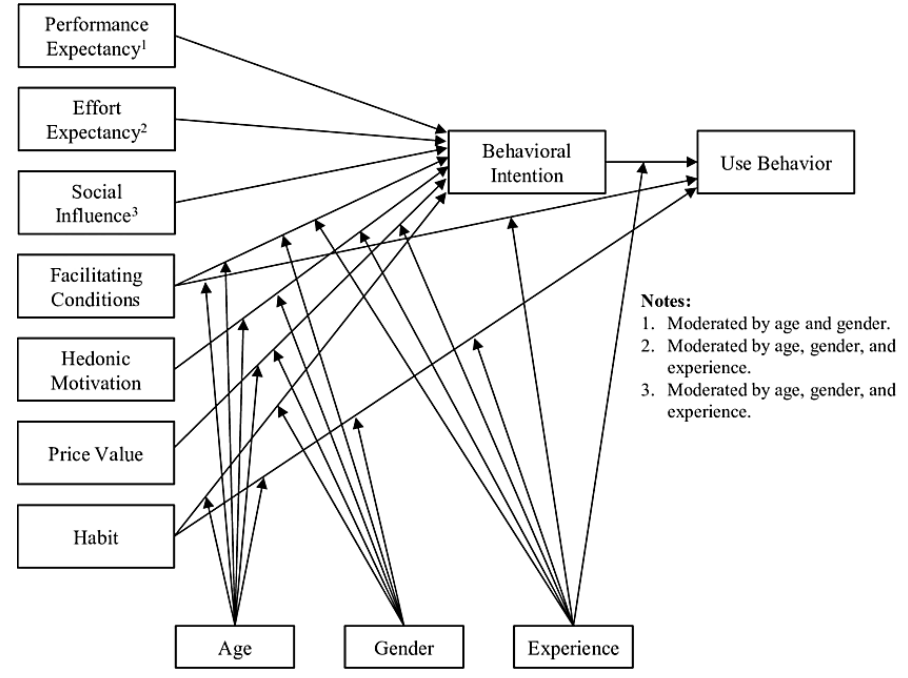
Figure 1. UTAUT-2 model Venkatesh et al. (2012)